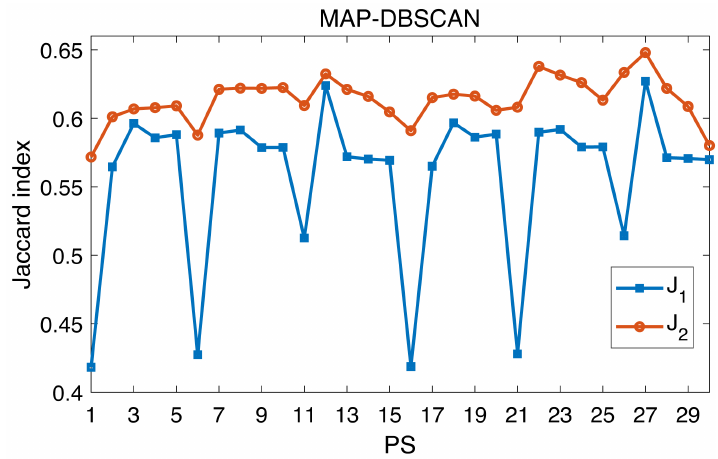
Figure A2. The Jaccard index values, J 1 with blue and J 2 with orange color, respectively, for all the input parameters of the MAP-DBSCAN method.